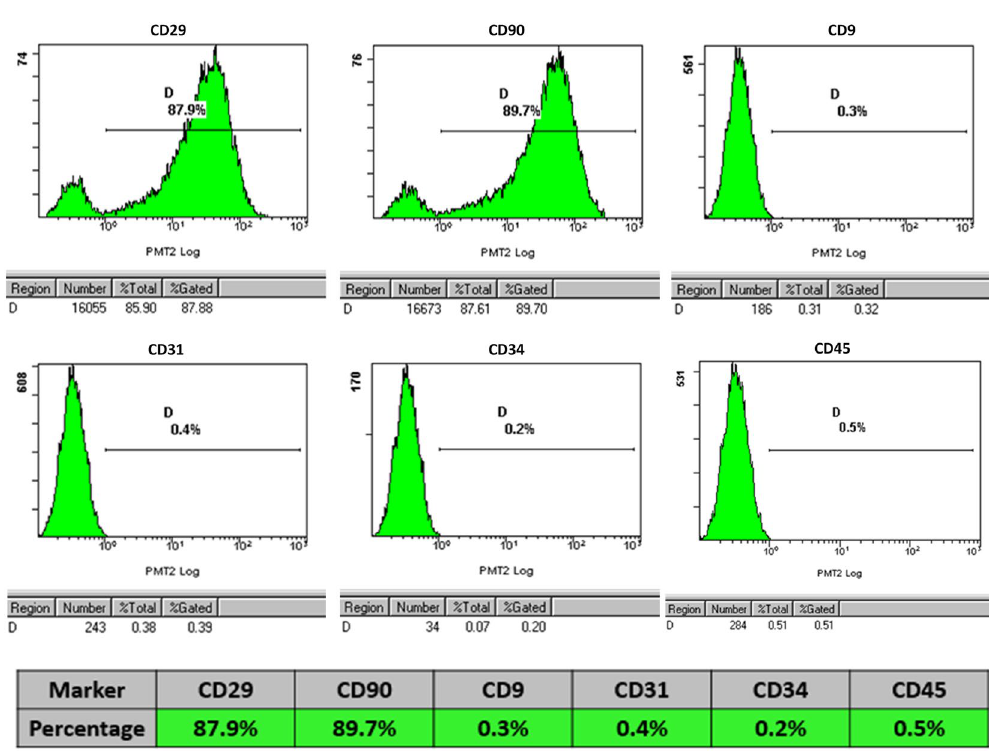
Figure 3. Cytometric flow analysis indicated that the cells in the research were negative for CD9, CD31, CD34 and CD45 but expressed the positive mesenchymal-associated markers CD29 and